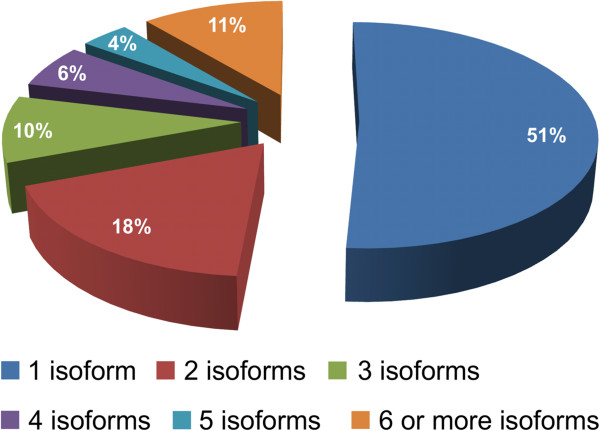
Isoform abundance in the assembled transcriptome. The percentage of the assembly possessing splice variants rang from a single transcript to 6 or more isoforms for a single gene.